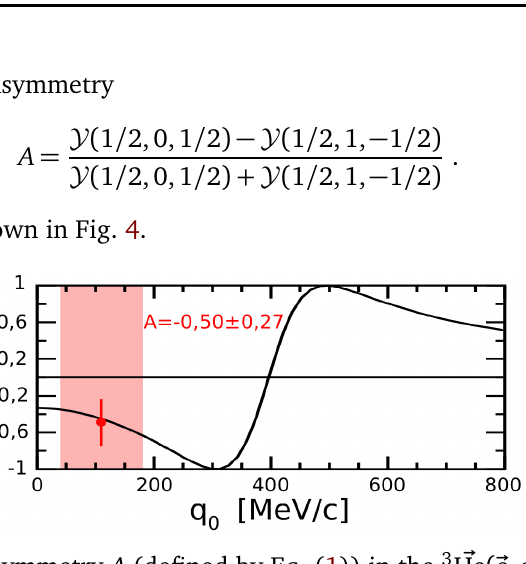
Figure 4: The asymmetry A (defined by Eq. (1)) in the 3